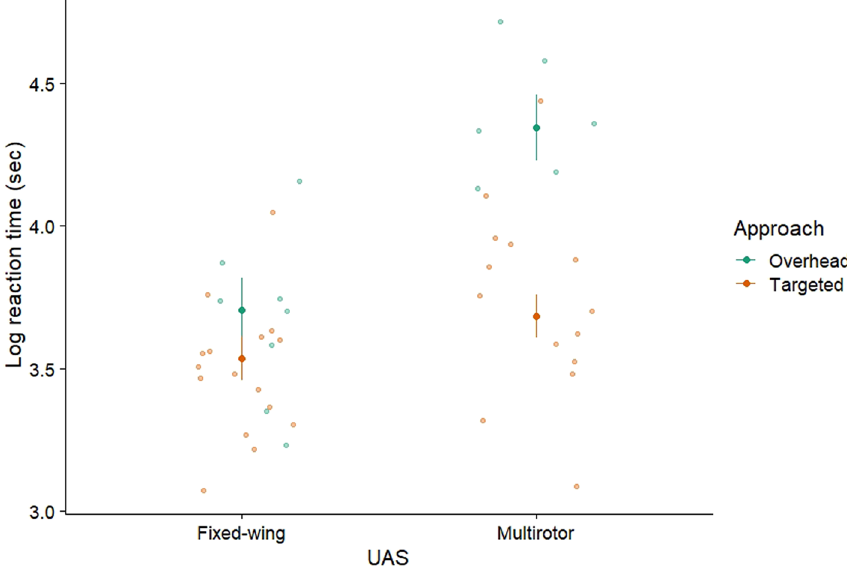
Figure 5. Interaction between the fixed effects of UAS platform and approach on vulture reaction time since reveal. Raw data are shown as points. Ornithopter treatments were removed because of low sample